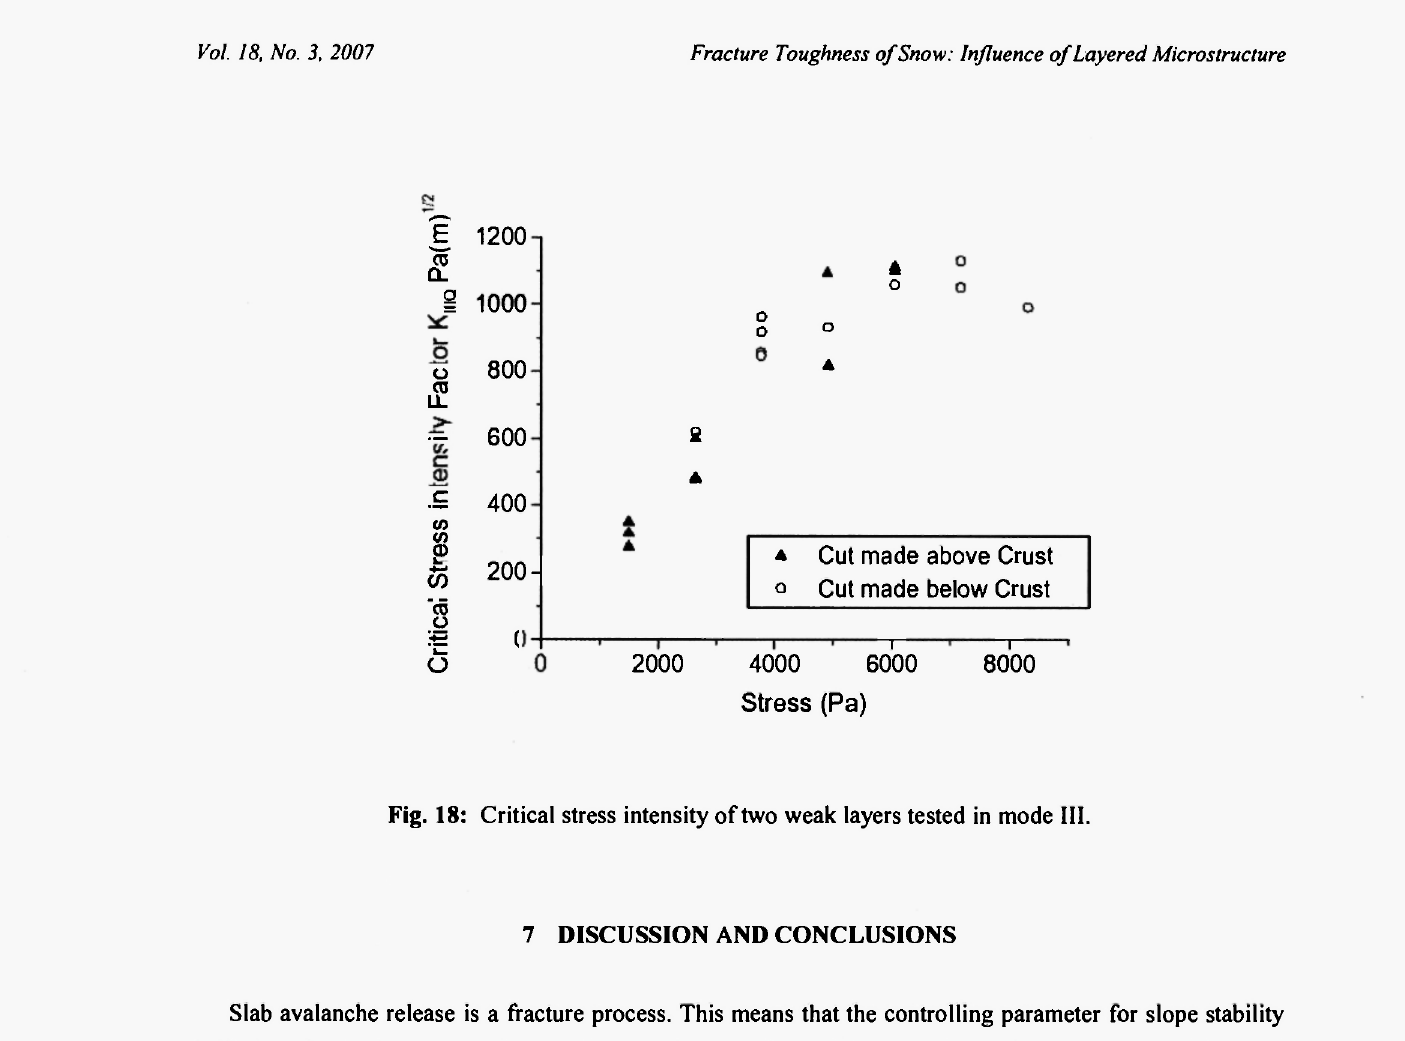
Fig. 18: Critical stress intensity of two weak layers tested in mode